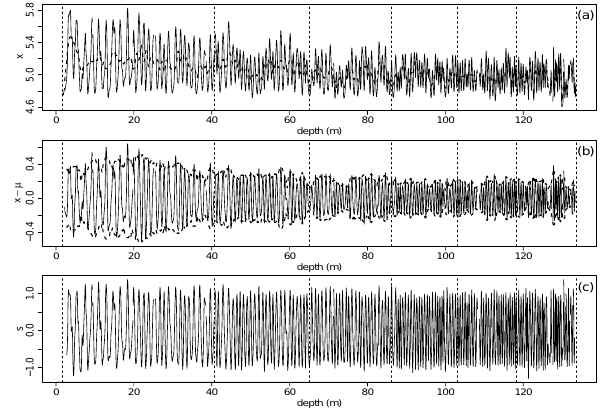
Fig. 2. The process of smoothing the H 2 O 2 signal from the Gomez core, using initial estimates of annual cycle length based on β = 6 sections – boundaries shown as vertical lines. (a) The log signal x , with its annual moving average µ as a dotted line. (b) The de- √ trended signal, with its estimated amplitude ( 2 σ ) as a dotted line. (c) The standardised signal s